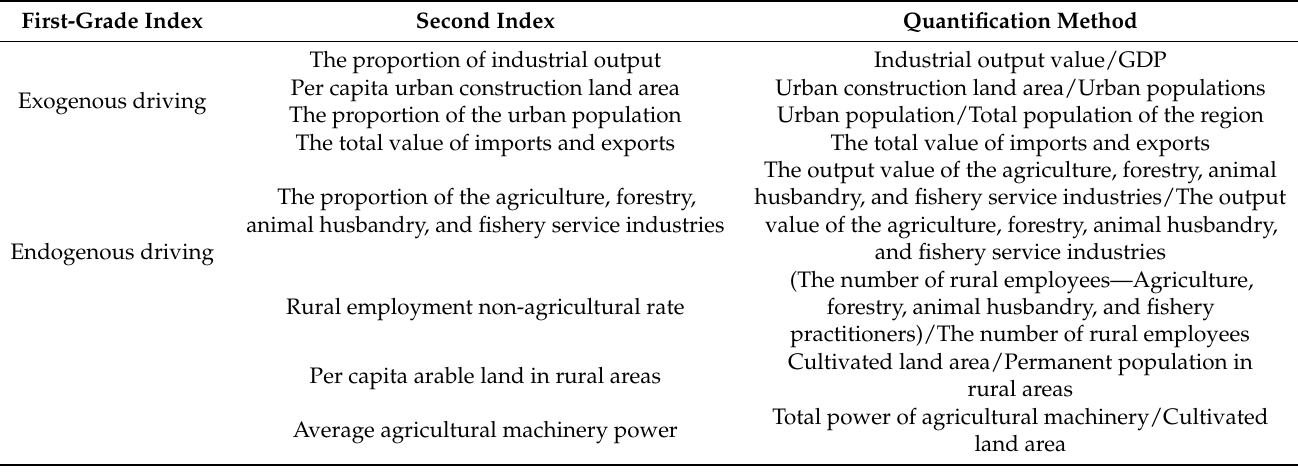
Table 2. Evaluation index system of the driving forces of rural